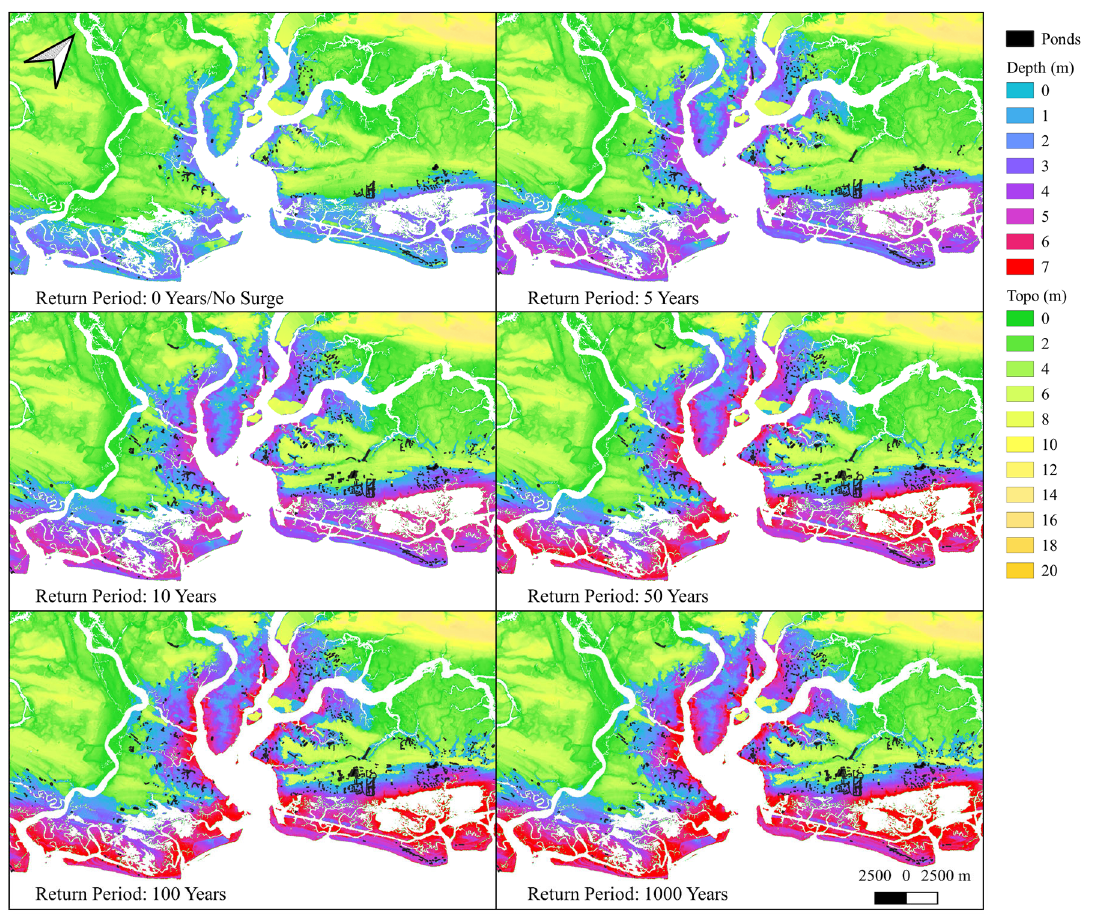
Figure 8. Charleston area inundation map (blue–red) caused by storm surge heights with different return periods under an SLR scenario of 2.0 m. The SMPs at risk are shaded black.